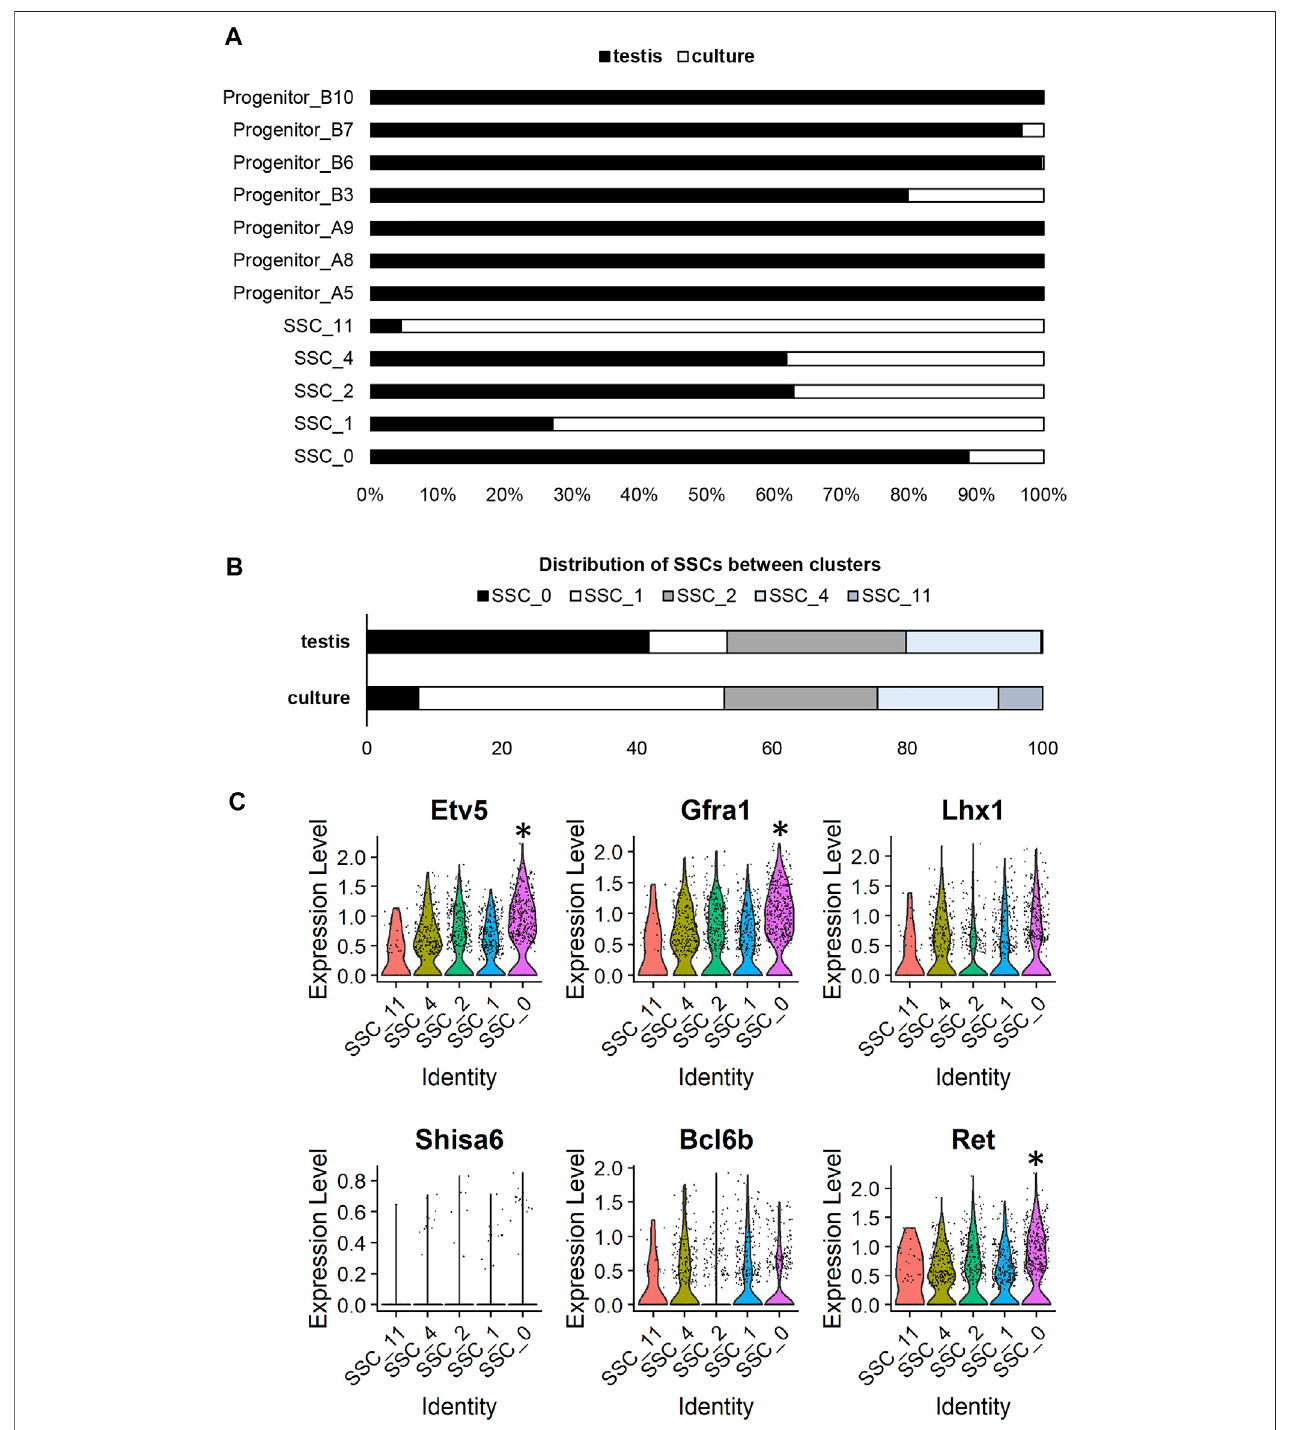
FIGURE 2 | Assessing cluster distribution and expression of self-renewal genes in undifferentiated spermatogonia from culture versus testis. (A) Composition of each cluster based on dataset origin (culture versus testis). (B) A comparison of the distribution of SSCs from the testis and culture datasets. (C) Violin plots depicting expression of genes previously reported to be involved in SSC maintenance. (* represents a signi fi cant difference at p < 0.001).